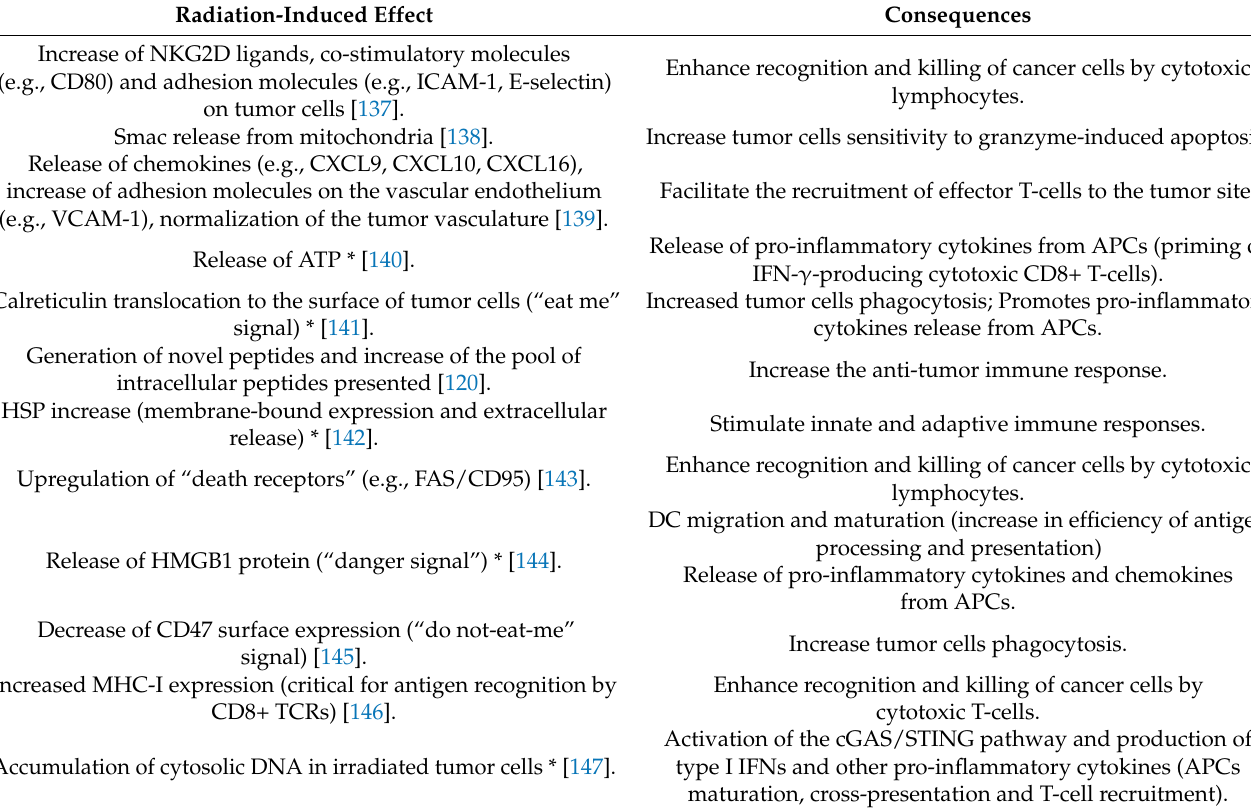
Table 3. Radiation-related immunostimulative